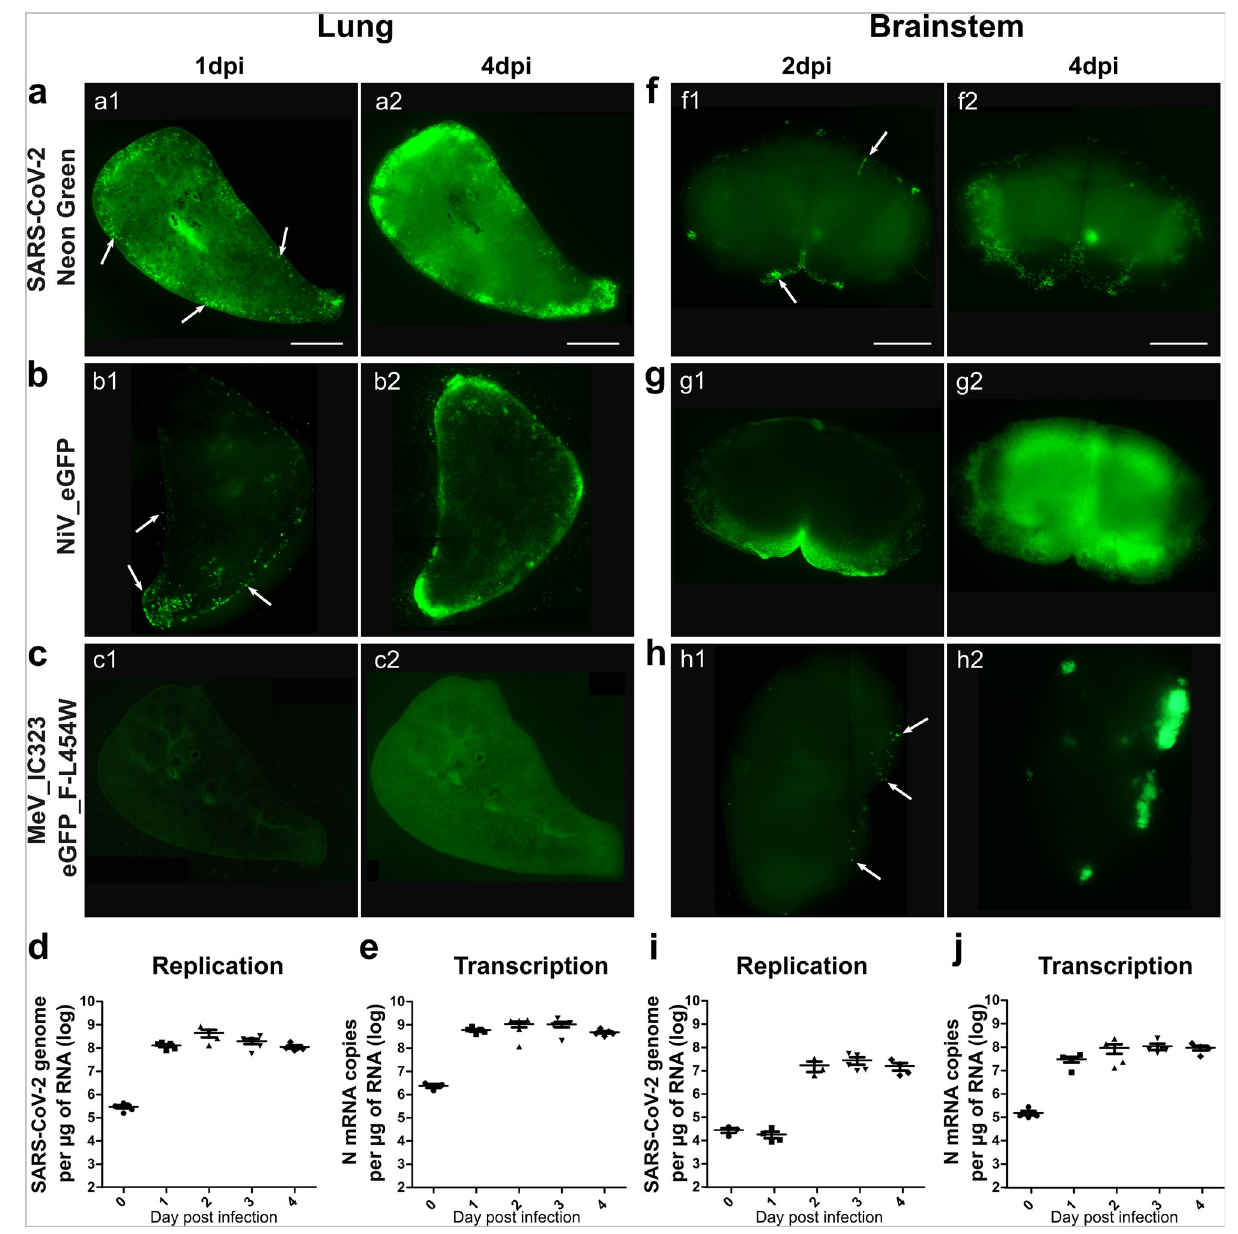
Fig. 2 Hamster organotypic culture infection by three respiratory viruses and the dissemination of SARS-CoV-2. a – c , f – h The entry of three different encephalitogenic respiratory viruses, icSARS-CoV-2-mNG (infection: 10,000 plaque-forming unit (pfu)), NiV-EGFP (infection: 5000 pfu) and the hyperfusogenic variant MeV IC323-EGFP-F L454W (infection: 1000 pfu) was monitored by following the fl uorescence at 1 dpi ( a1 ; b1 ; c1 ), or 2 dpi ( f1 ; g1 ; h1 ) and 4 dpi ( a2 ; b2 ; c2 ; f2 ; g2 ; h2 ). Pictures were taken using a Nikon Eclipse Ts2R microscope (500 ms of exposure), reconstituted using the Stitching plug-in with ImageJ software 119 and are representative of three independent experiments. Scale bar = 1 mm. d , i SARS-CoV-2 genomes per µ g of total RNA and e , j SARS-CoV-2 N mRNA copies per µ g of total RNA were quanti fi ed by RT-qPCR in the lung, and brainstem organotypic cultures at 90 min post infection and 1 – 4 days post infection (dpi) with 5000 pfu and normalized to the standard deviation for GAPDH mRNA. ( n = 5 biologically independent animals). Source data are provided as a Source Data fi